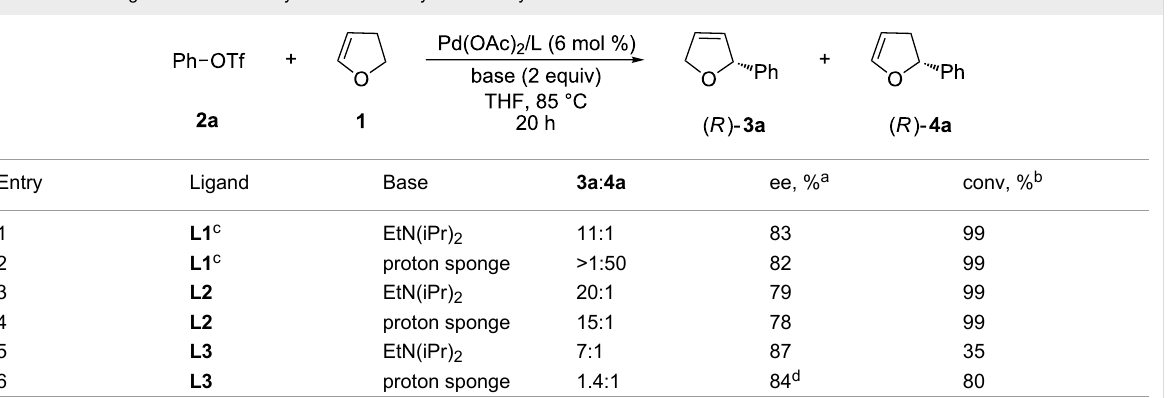
Table 2: Screening of L1 – L3 in the asymmetric Heck arylation of dihydrofuran 1 .